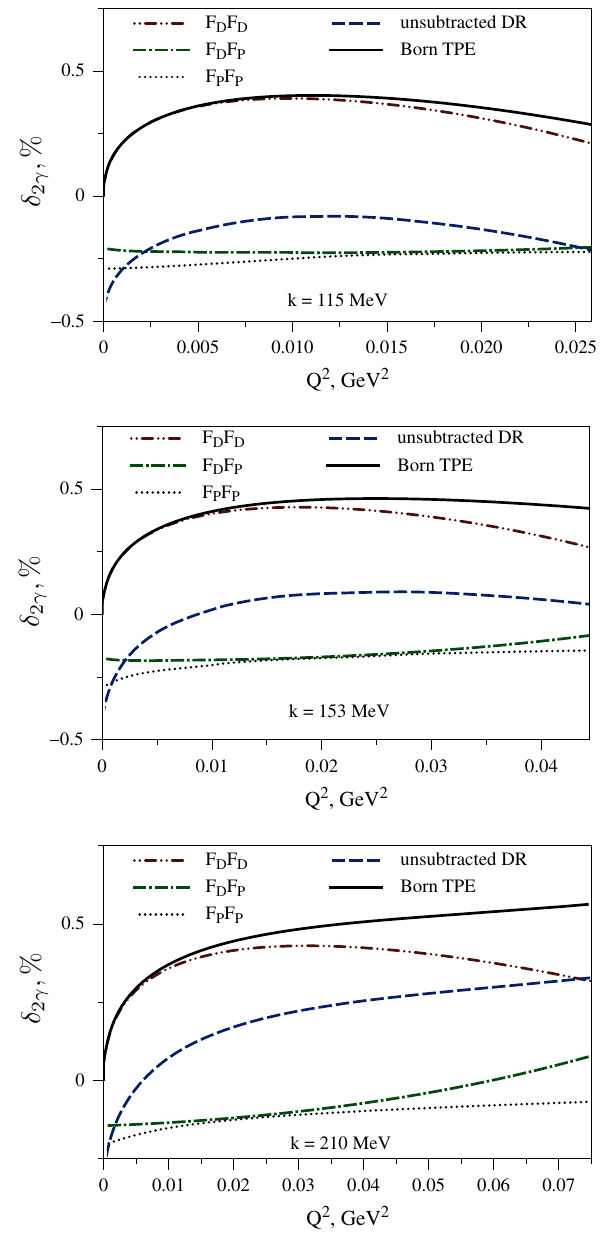
Fig. 9 TPE correction to the unpolarized elastic μ − p cross section evaluated for three nominal muon beam momenta within the unsub- tracted DR framework. The total correction is shown by the blue dashed curves, the contribution from the F D F D structure of photon–proton– proton vertices is shown by the red double-dotted curves, the contribu- tion from the F D F P structure by the green dashed-dotted curves, and the contribution from the F P F P structure by the black dotted curves. For comparison, the evaluation in the box diagram model (Born TPE) is shown by the solid black curves